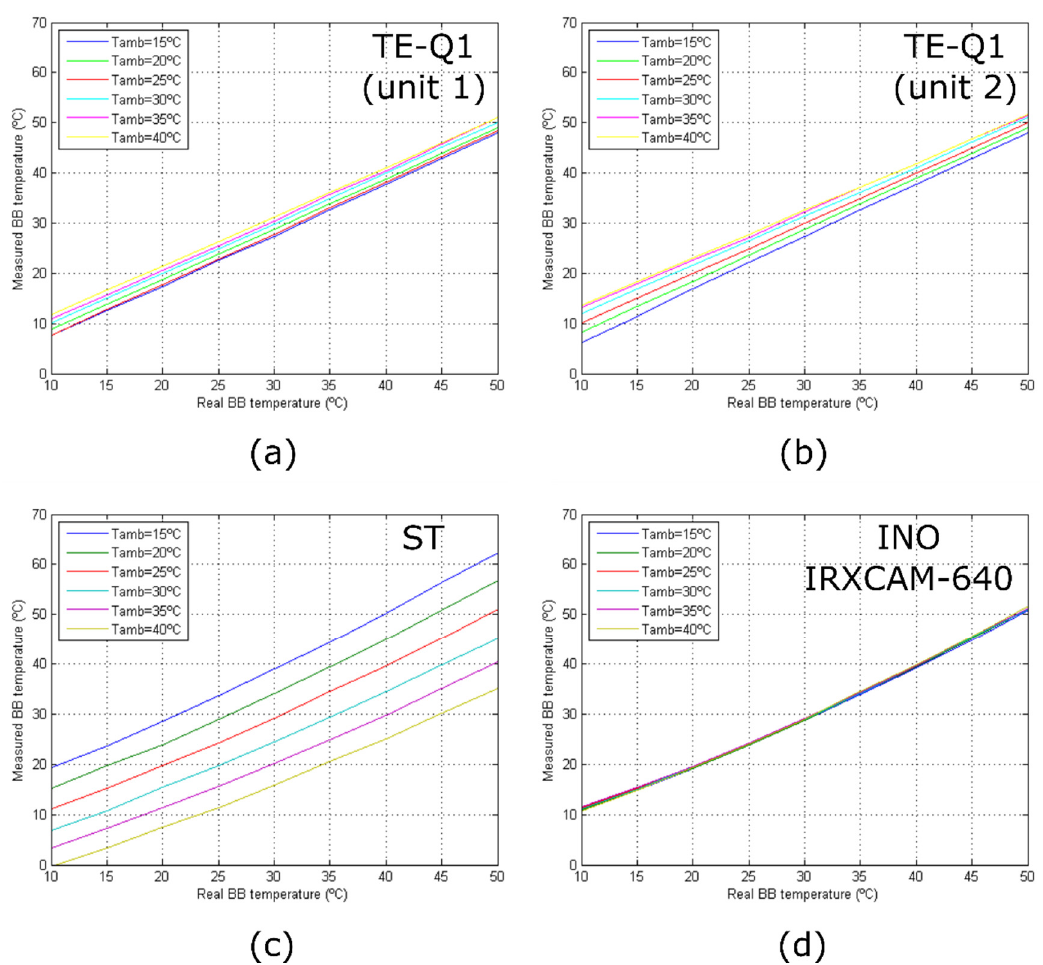
Figure 6. Camera response curves for different room temperatures: ( a ) TE-Q1 (unit 1); ( b ) TE-Q1 (unit 2); ( c ) ST; ( d ) INO IRXCAM-640. The curves are color-coded depending on the room temperature as seen in the legend.